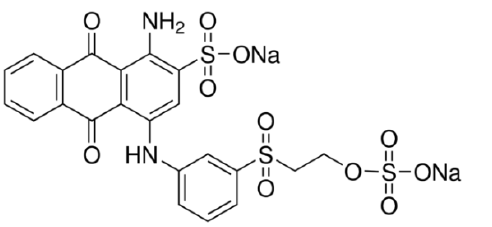
Figure 1. Chemical structure of Remazol Brilliant Blue R (Reactive Blue 19)